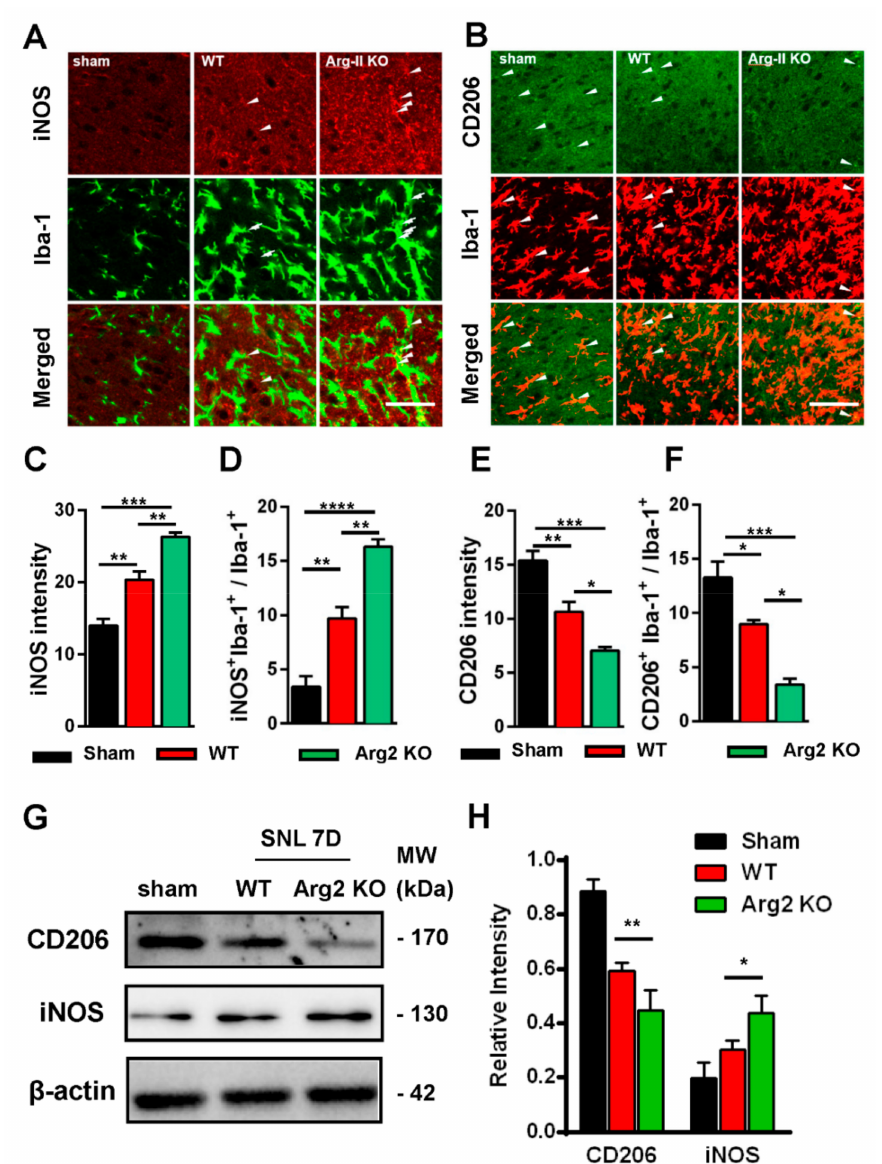
Figure 5. Upregulation of inducible nitric oxide synthase (iNOS) and downregulation of CD206 in the spinal dorsal horn of mice following SNT surgery. ( A , B ) Representative immunohistochemical staining images of spinal cord sections on day 7 post-surgery using iNOS and CD206 antibodies and co-stained with Iba-1 (a microglial marker). The immunoreactivities of iNOS (arrowheads in A ) and CD206 (arrowheads in B ) overlapped with Iba-1 microglia. The expression of iNOS increased in WT ( n = 3) and was notably the highest in Arg2 KO mice ( n = 3). In contrast, the expression of CD206 decreased, particularly in Arg2 KO mice. Scale bar = 50 µ m. ( C , D ) Quantification of iNOS immunodensity and iNOS + / Iba-1 + co-positive cells / total Iba-1 + cells revealed upregulation of iNOS in mice following SNT surgery. ( E , F ) Quantification of CD206 immunodensity and CD206 + / Iba-1 + co-positive cells / total Iba-1 + cells exhibited downregulation of CD206 in mice after surgery. ( G , H ) Expression of iNOS and CD206 was assessed by western blotting of the spinal dorsal horns of mice on day 7 post-surgery. Quantification of the blots also indicated upregulation of iNOS and downregulation of CD206. Data are presented as means ± SEM (one-way ANOVA with Tukey’s post hoc test, F (2,6) = 46.15 ( C ), F (2,8) = 47.26 ( D ), F (2,7) = 28.81 ( E ), F (2,6) = 28.86 ( F ), F (2,2) = 0.1073 and F (1,2) = 2.801 ( H ). **** p < 0.0001, *** p < 0.001, ** p < 0.01, and * p < 0.05 versus WT or